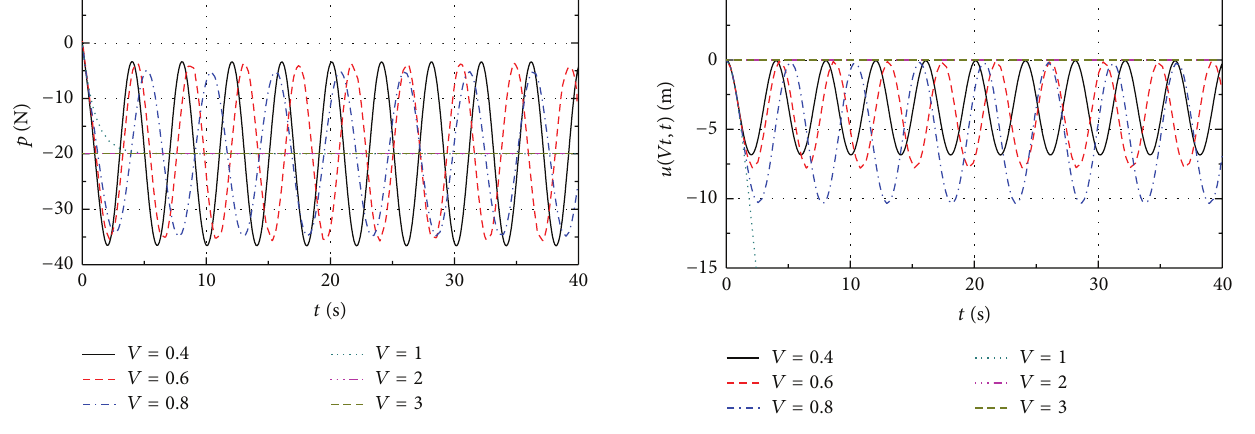
Figure 6: The displacement of the contact